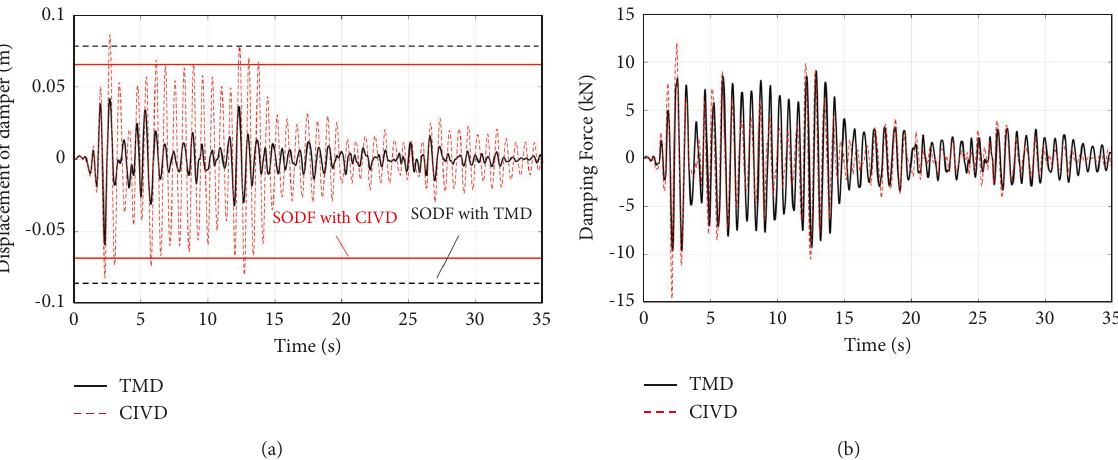
Figure 15: Response of damping element of CIVD and TMD under El Centro wave: (a) displacement; (b) damping force.